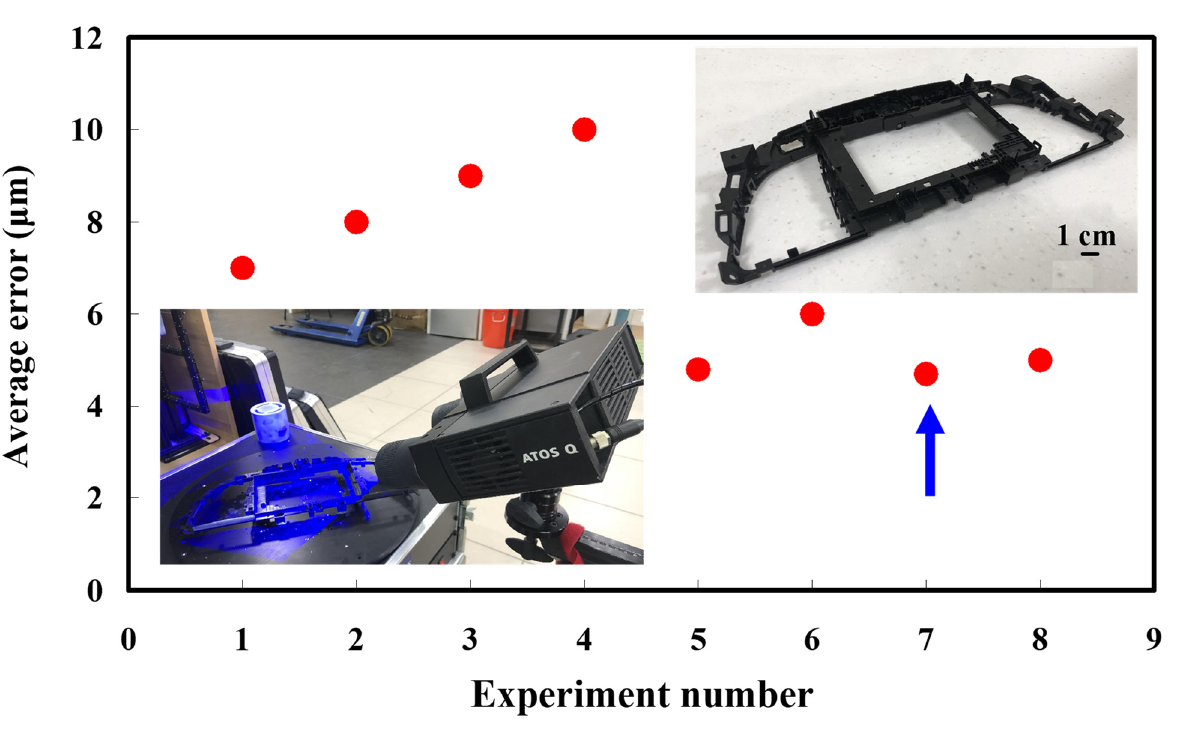
Figure 12. Average error of eight different measurement methods compared with conventional method for dark plastic part.